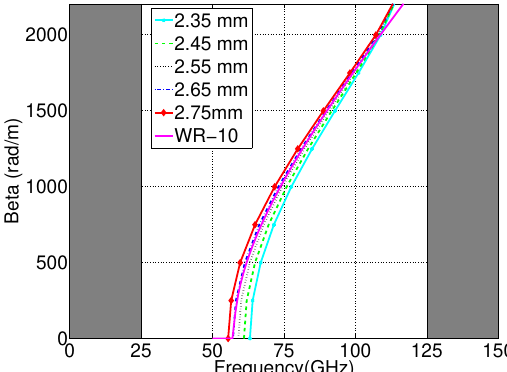
Figure 3. Comparison of the propagation constant of width ( w ) groove gap waveguides and a WR10 standard rectangular waveguide. The gray areas correspond to the limits of the bandgap of the bed of